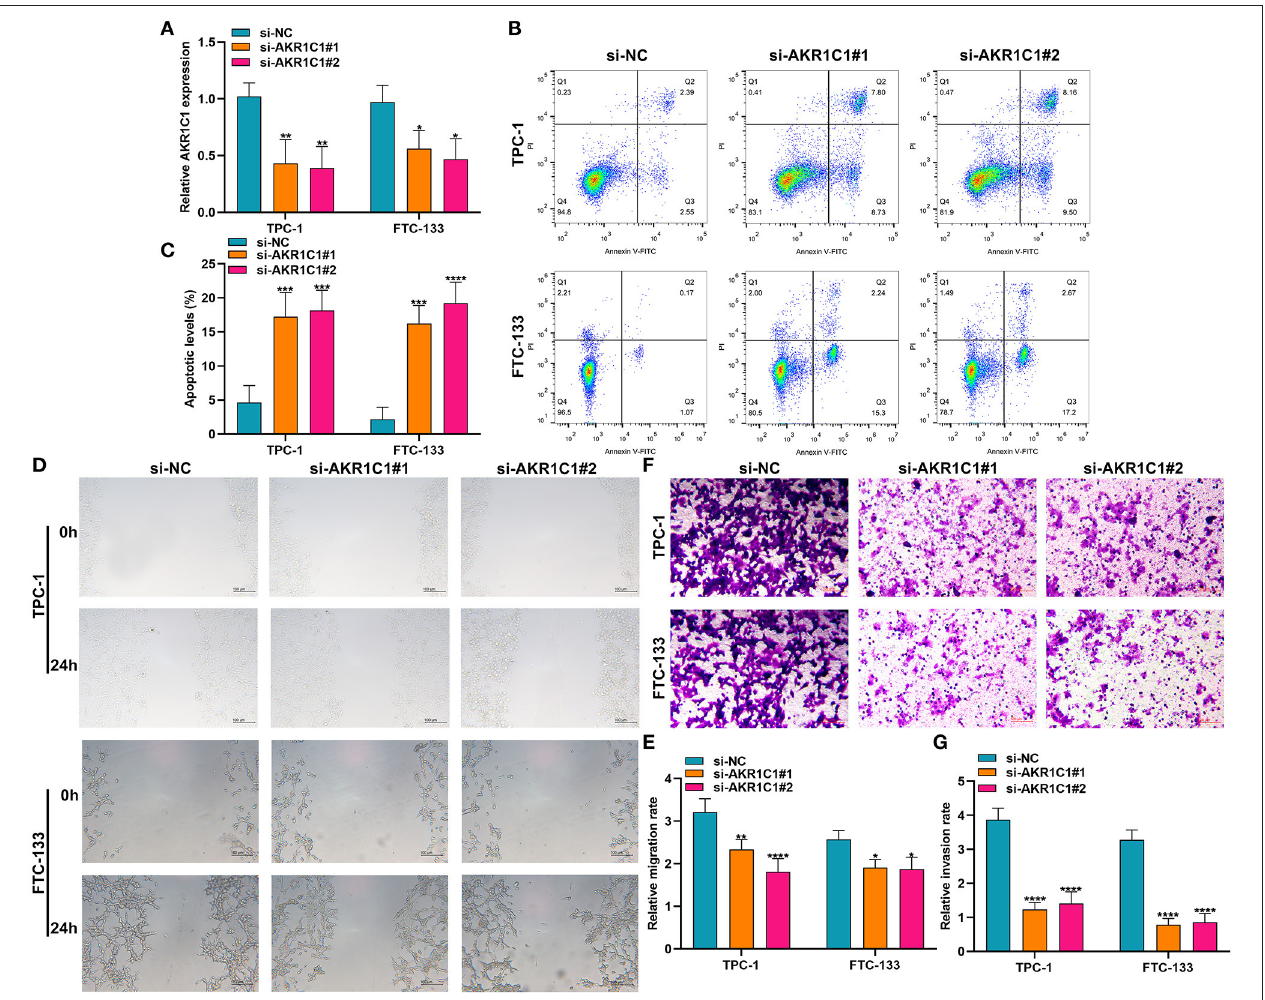
FIGURE 9 | The effects of AKR1C1 knockdown on apoptosis, migration, and invasion in thyroid cancer cells. (A) RT-qPCR for the mRNA expression of AKR1C1 in TPC-1 and FTC-133 cells transfected with si-AKR1C1. (B,C) Flow cytometry detecting the apoptosis of si-AKR1C1-transfected TPC-1 and FTC-133 cells. (D,E) Wound healing for the migration of TPC-1 and FTC-133 cells transfected with si-AKR1C1. (F,G) Transwell for the invasion of TPC-1 and FTC-133 cells transfected with si-AKR1C1. * p < 0.05; ** p < 0.01; *** p < 0.001; **** p <